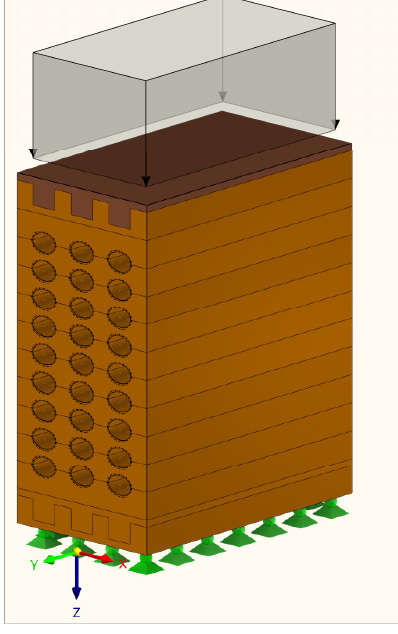
Figure 8. FEM—loading scheme.